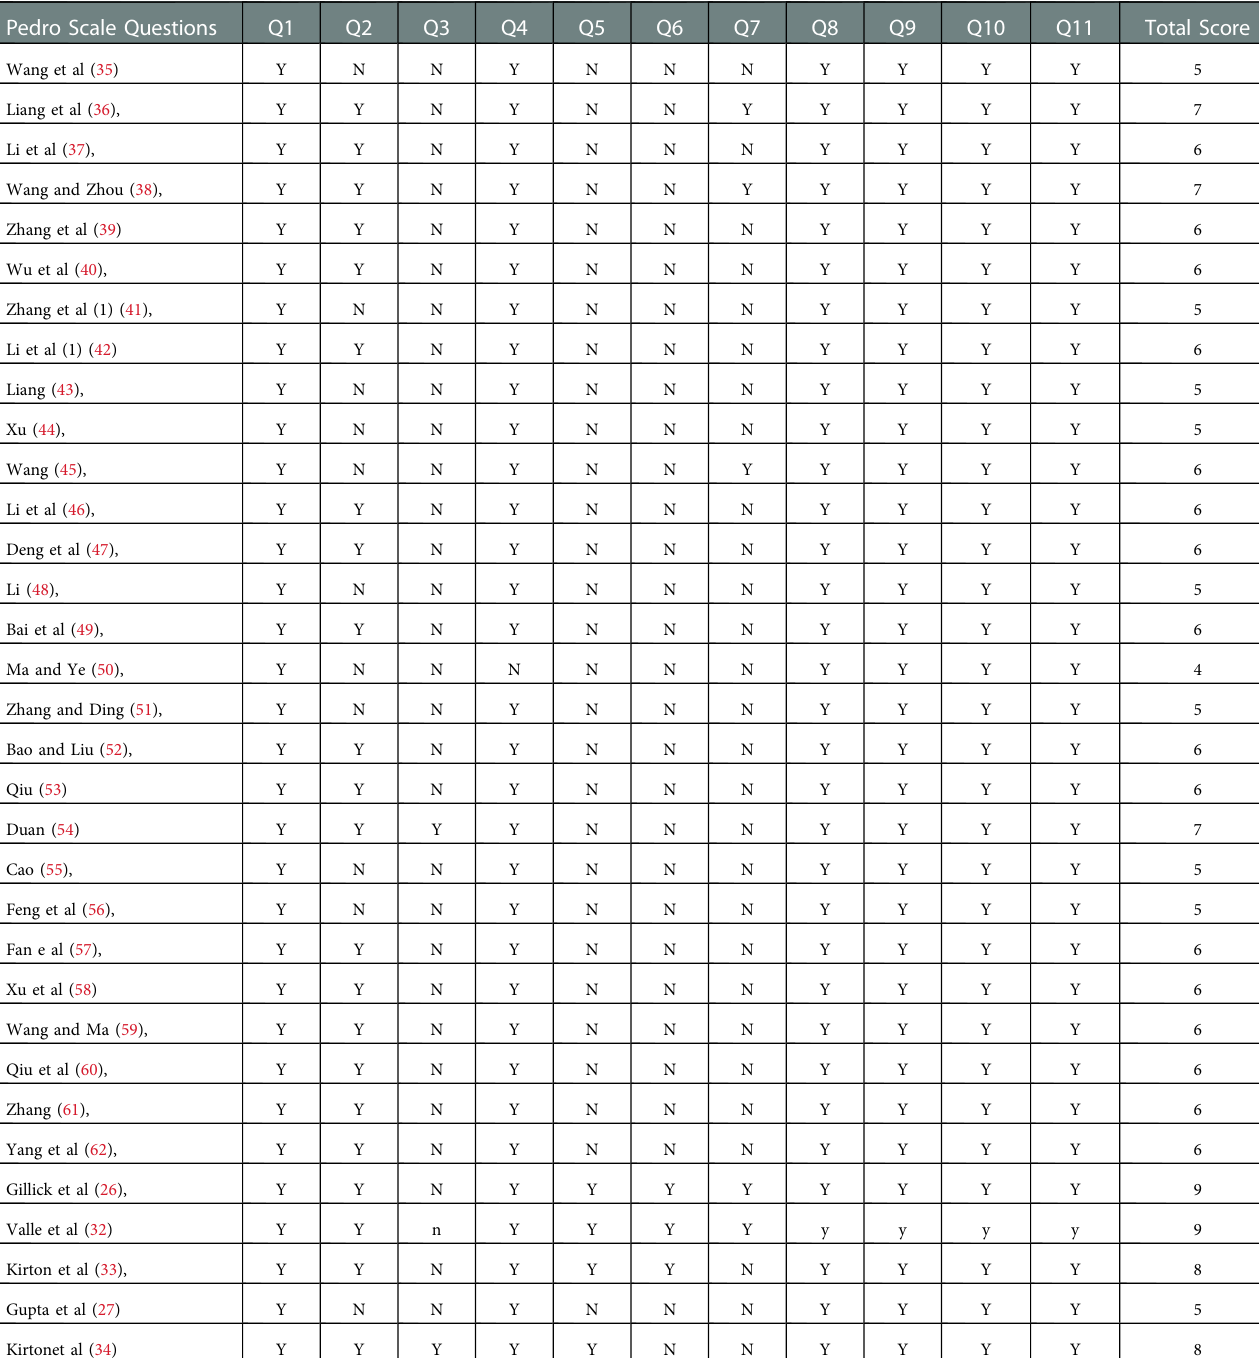
TABLE 1 The studies evaluated according to the PEDro scale. Pedro Scale